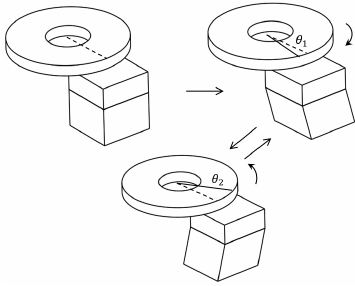
Figure 3. Input voltage of PZT.